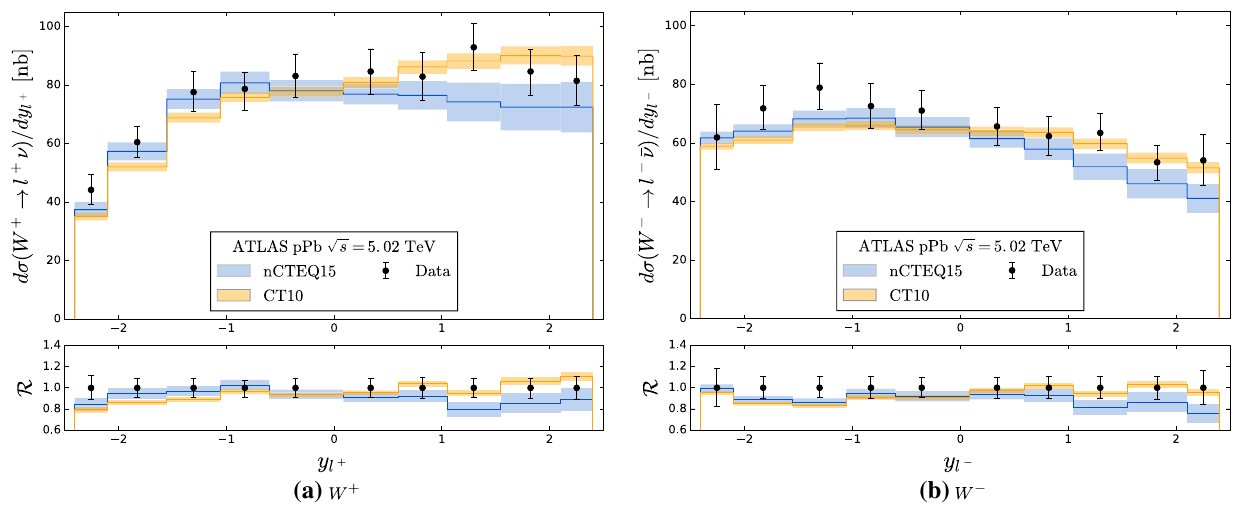
Fig. 7 ATLAS W ± production in pPb collisions at the